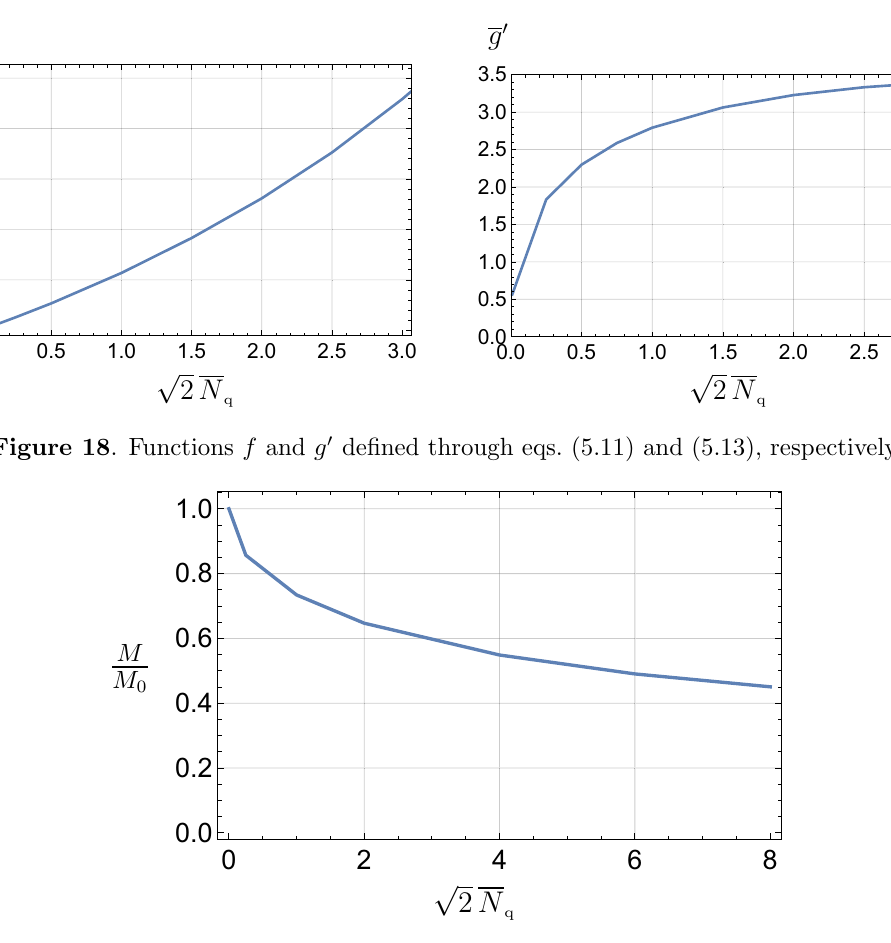
Figure 19 . Mass of a string stretching from the origin of a zero-temperature solution to the position = 0. of the LP as a function of the charge density, normalized to the value at N q in contrast to C and similarly to χ , c 2 is also negative in the IR region of Q s arbitrarily low temperature and √ 2 N 4 . q (cid:31)